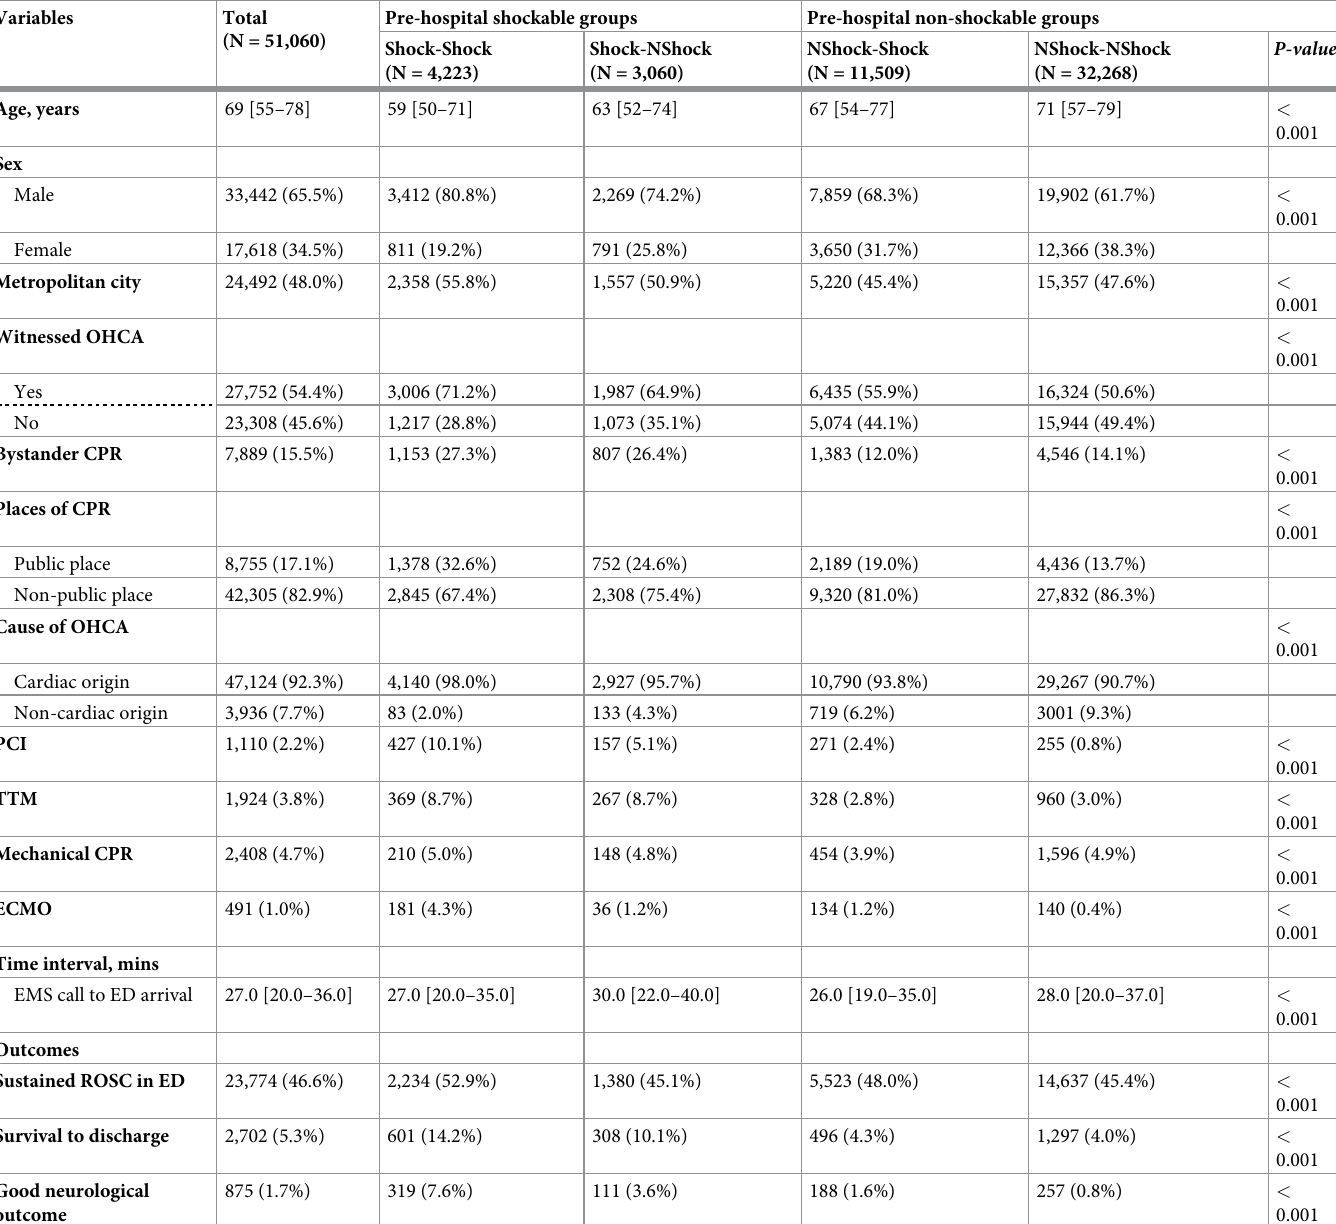
Table 1. Baseline characteristics and resuscitation variables according to cardiac arrest rhythm in the OHCA patient without ROSC.